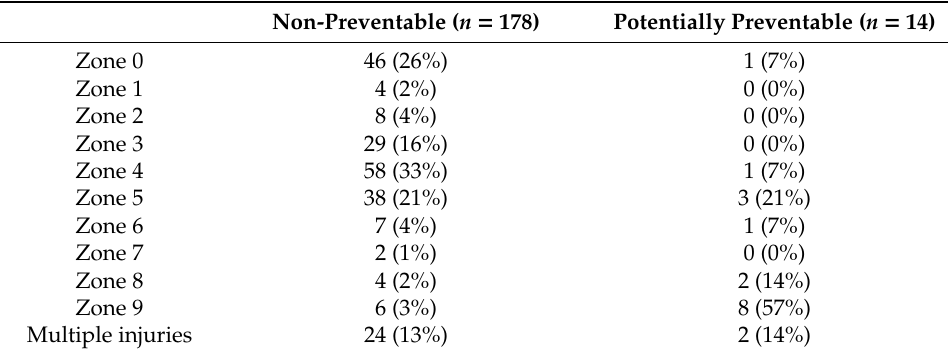
Table 2. Location of aortic injury by proximal zone.